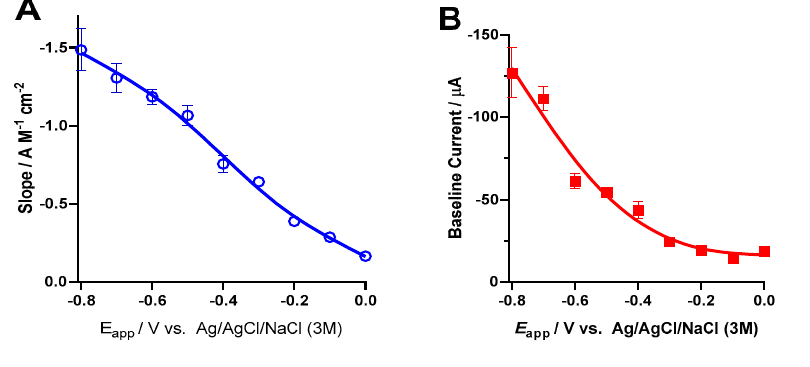
Figure 5. Electrochemical impedance spectroscopy measurements obtained in K 4 [Fe(II)(CN) 6 ]/K 3 [Fe(III)(CN) 6 ] (5mM) in KCl 0.5M. ( A ) Impedance − frequency plot (Bode plot). Filled circles represent | Z | values, and open circles are those obtained for the phase shift. The red circle highlights the | Z | value at 1 kHz. ( B ) Complex plane electrochemical impedance spectrum (Nyquist plot) of experimental data (open circles). Red line shows fitting to the electrical equivalent circuit shown in the inset. R1, solution resistance; R2, electron or charge transfer resistance; W, Warburg impedance element; Q, constant phase element.